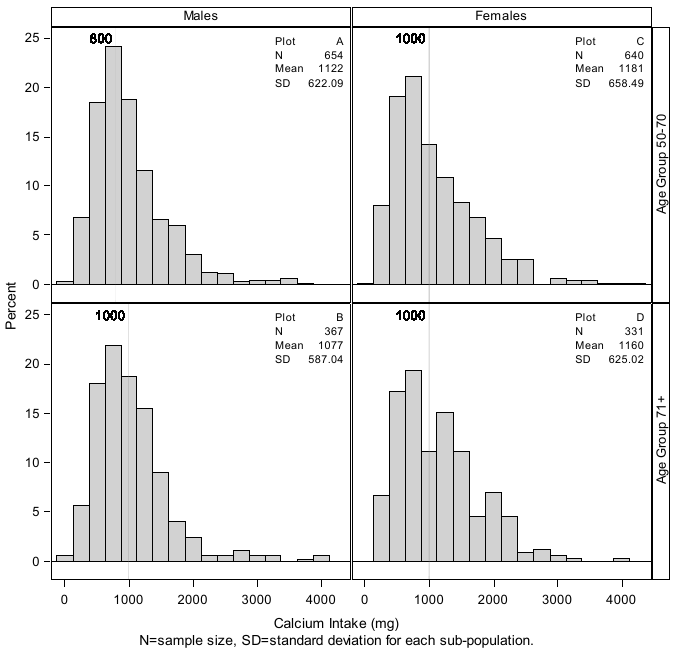
Figure 1. Summary and distributions of total calcium intake with RDAs. Histograms showing the distribution of total calcium intake including supplemental consumption by gender and age group with vertical lines representing RDA amounts. 57.00% of younger males consume more than 800 mg of Calcium per day, 13.00% more than females of the same age group, plots A and C . Only 42.69% of older males consume more than 1000 mg of calcium per day, 7.61% less than that consumed by older females, plots B and D .